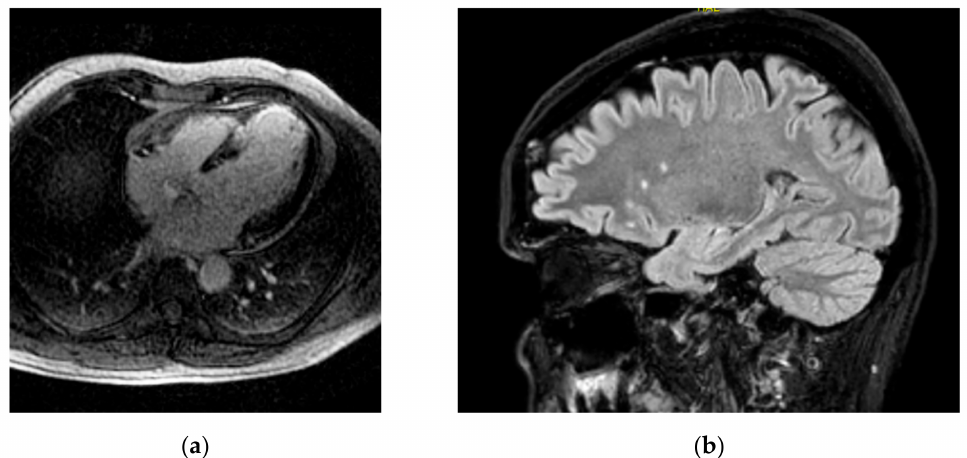
Figure 1. Combined brain/heart MRI images from a patient with CD and HF ( a ) inversion recovery image showing extensive myocardial LGE due to myocardial infarction; ( b ) brain FLAIR image showing WMH in the same